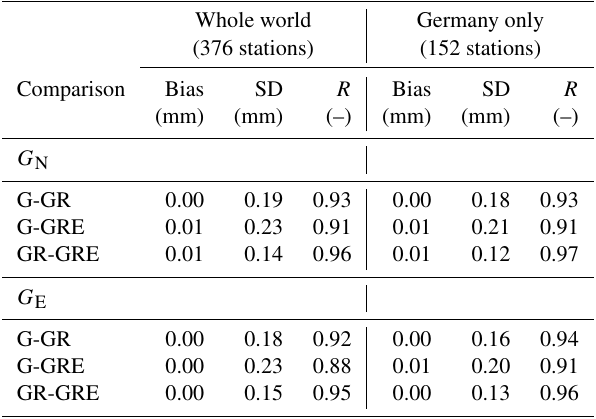
Table 5. Biases, SDs and Pearson’s correlations between the three GNSS solutions for tropospheric gradients averaged from the year 2020 and all stations.